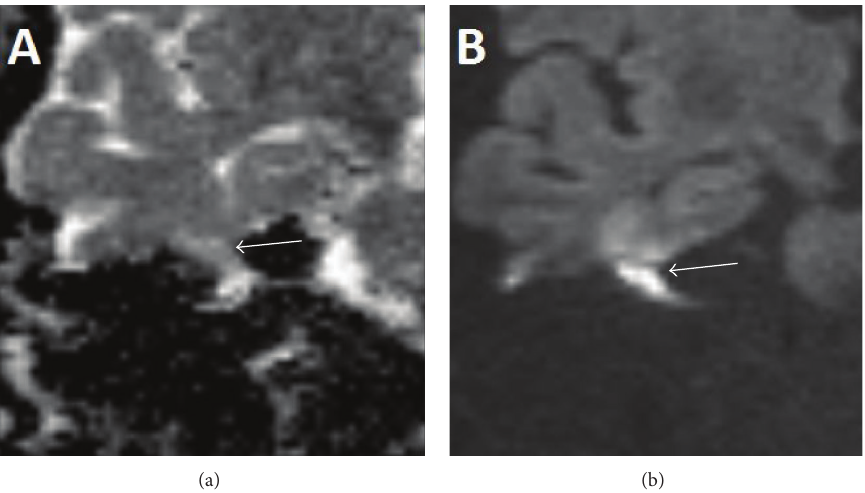
Figure 3: ADC imaging (a) and diffusion imaging (b) demonstrating restricted diffusion of lesion ( white arrows